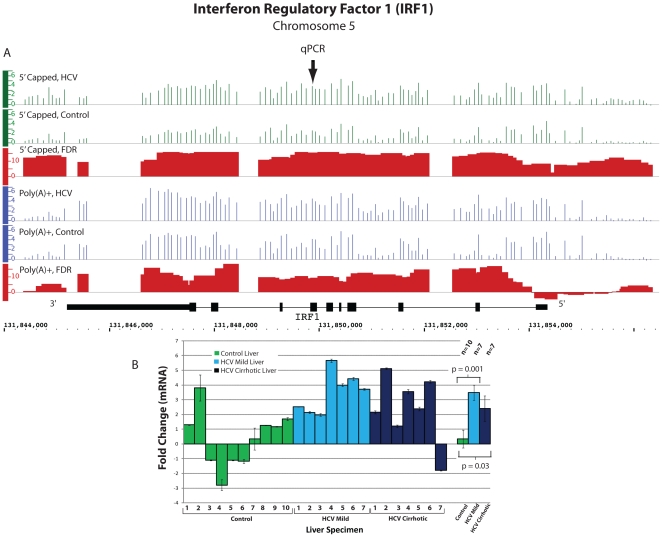
Differential expression of IRF1 in HCV cirrhotic as
compared to control liver.
Panel A. Expression of IRF1 as measured by
signal intensity on ENCODE tiling arrays is displayed using the Integrated
Genome Browser (IGB). The y-axis represents the log2 transformation of the
normalized signal divided by the background signal on arrays and each bar
represents the normalized signal intensity of probes hybridized to 60mer
targets tiled across the gene region (Methods). Genomic regions that are
tiled yet lack a signal are indicated by a baseline tick mark. Absence of a
tick mark indicates no probes in that region. Gene structure, orientation,
and chromosomal location are shown in black. Average RNA expression based on
the analysis of 5′ capped RNA isolated from HCV cirrhotic and control
liver is depicted in green for both HCV cirrhotic and control liver. Average
RNA expression using poly(A)+ RNA is depicted in blue. Differences in
expression between HCV cirrhotic and control liver for poly(A)+ and
5′ capped RNA populations are depicted as window level false discovery
rates in red (-10Log10 FDR) (see Methods). A transformed FDR of ≥13 (represents an
untransformed FDR ≤0.05 or 5 false positives out of 100) was considered
statistically significant. Panel
B. qPCR was performed as described in Methods. Triplicate samples from seven HCV cirrhotic,
seven mild HCV (no fibrosis), and ten control livers were analyzed. HCV
Cirrhotic 1 and Control 1 refer to the original samples used for the ENCODE
tiling array analysis. The mean ± SEM fold change for each specimen
analyzed is shown and the location of the qPCR primers is indicated by qPCR
in Panel A. P-values were calculated using the Student's t-test.